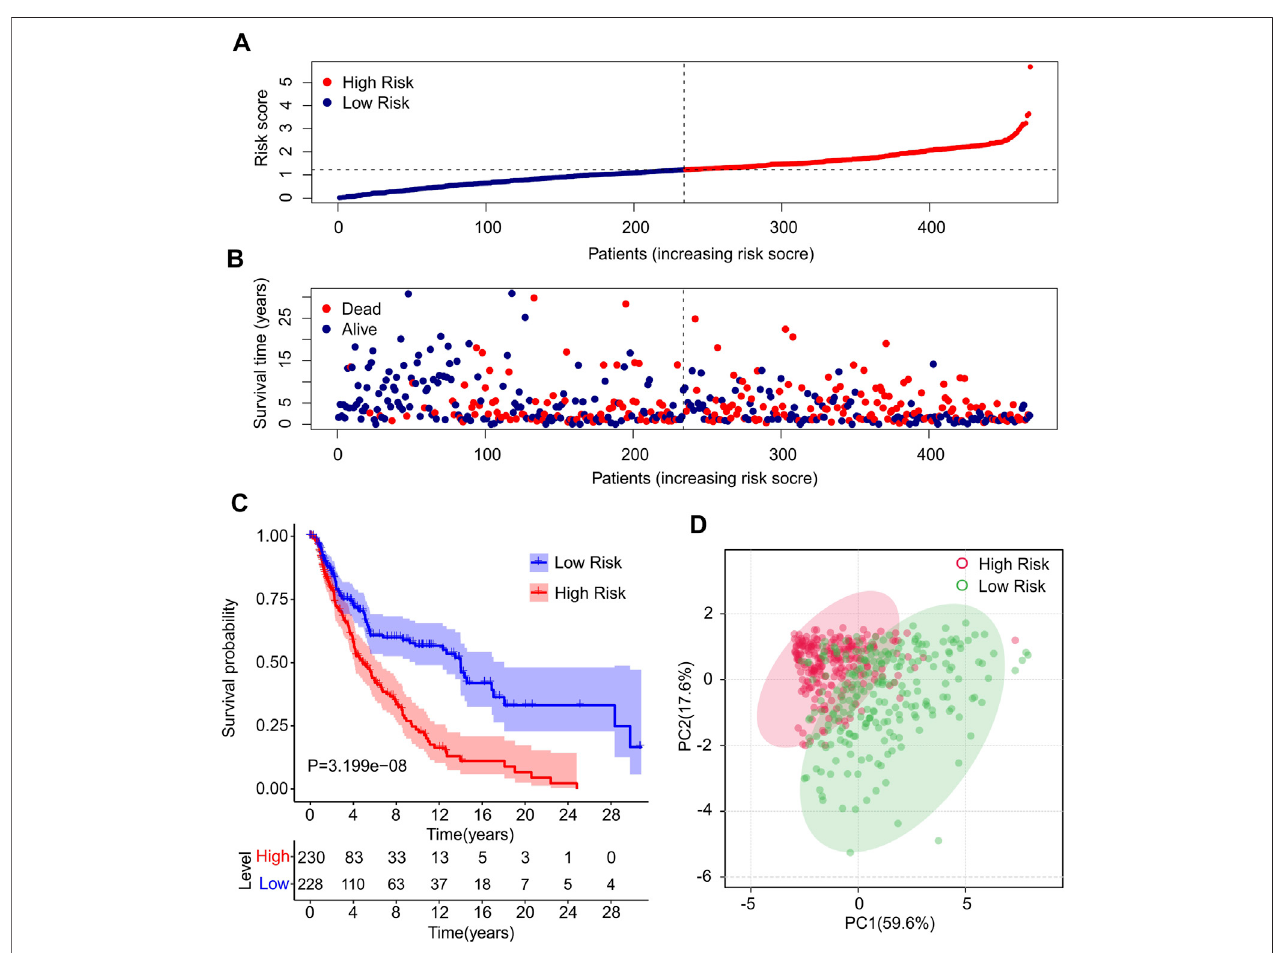
FIGURE2| Construction ofprognosticcharacteristics and riskmodel in CMpatients. (A) Distribution ofriskscoresin high- and low-risk CMpatientsbased on the autophagy-related lncRNAs prognostic signature. (B) The scatter dot plot illustrates the correlation of survival time and risk scores of CM patients based on the autophagy-related lncRNAs prognostic signature. (C) The Kaplan-Meier survival curve analysis shows that the survival time of CM patients with high-risk scores is signi fi cantlyshorterthanthosewithlow-riskscores. (D) Principalcomponentsanalysis(PCA)showsasigni fi cantseparationbetweenhigh-riskandlow-riskgroups based on 10 autophagy-related